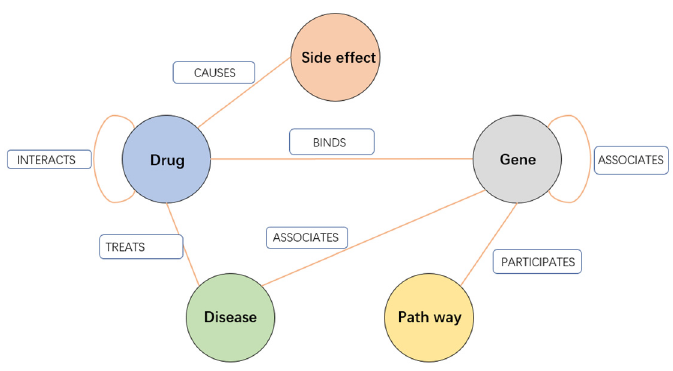
Figure 1. Data schema of our drug knowledge graph (KG).